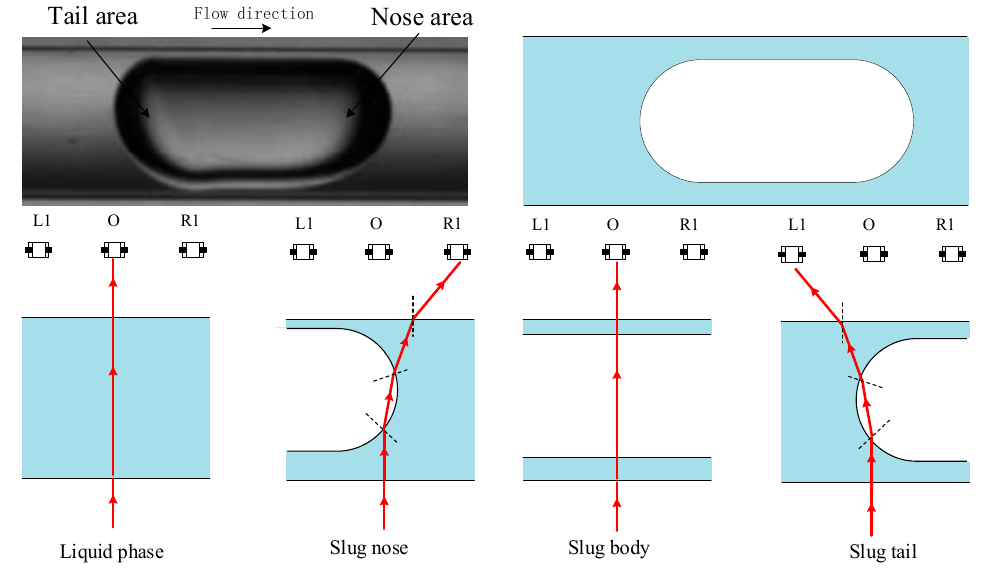
Figure 6. Basic conditions of laser paths related to the interfaces of slug flow.